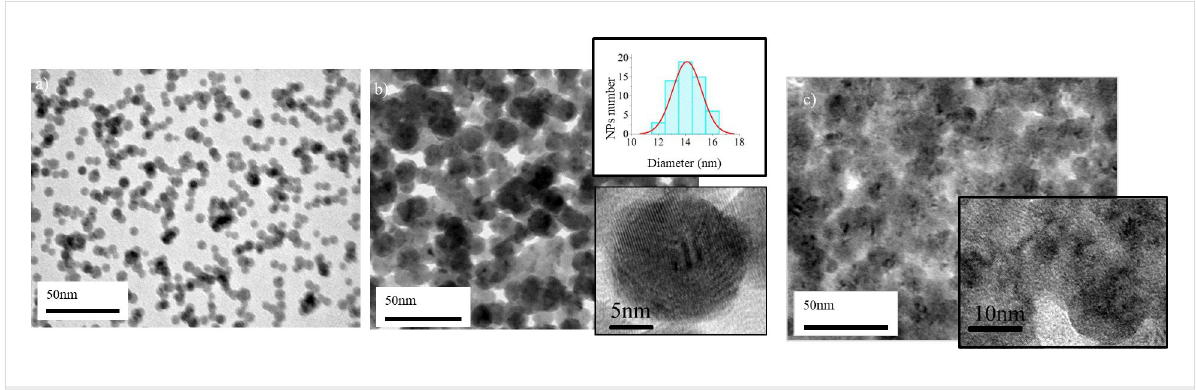
Figure 5: TEM showing the morphology of Hf NPs deposited at different substrate voltages V s : a) V s = 0 kV; the mean diameter is 9.5 nm. b) V s = 2 kV; the impact energy leads to nanoparticle flattening. The mean diameter of the flattened NPs is 14 nm. c) V s = 4.5 kV; the increment of impact energy leads to further deformation of the